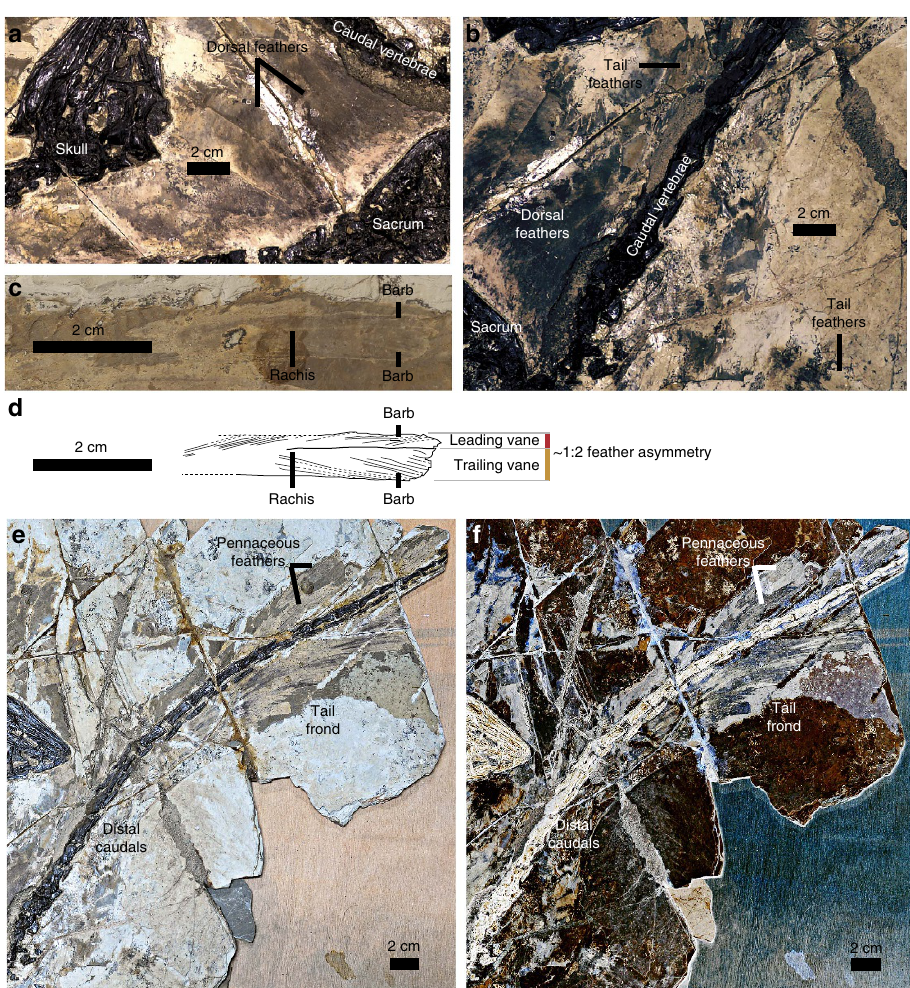
Figure 5 | Plumage of Jianianhualong tengi holotype DLXH 1218. ( a ) Feathers over dorsals, ( b ) feathers attached to anterior caudals, ( c ) asymmetrical tail feather, ( d ) line drawing of asymmetrical tail feather, ( e ) tail frond and ( f ) negative LSF image of tail frond. All scale bars,